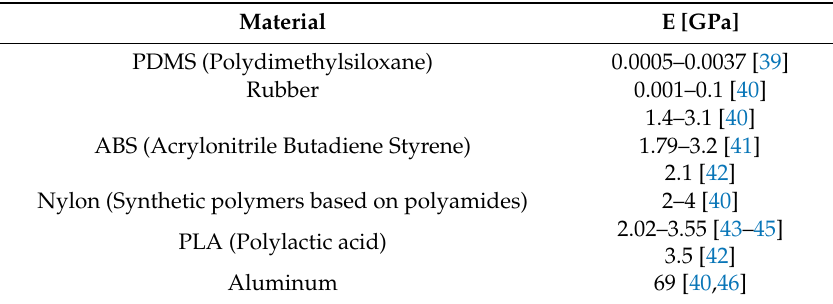
Table 3. Modulus of elasticity reference values of the di ff erent materials analyzed.